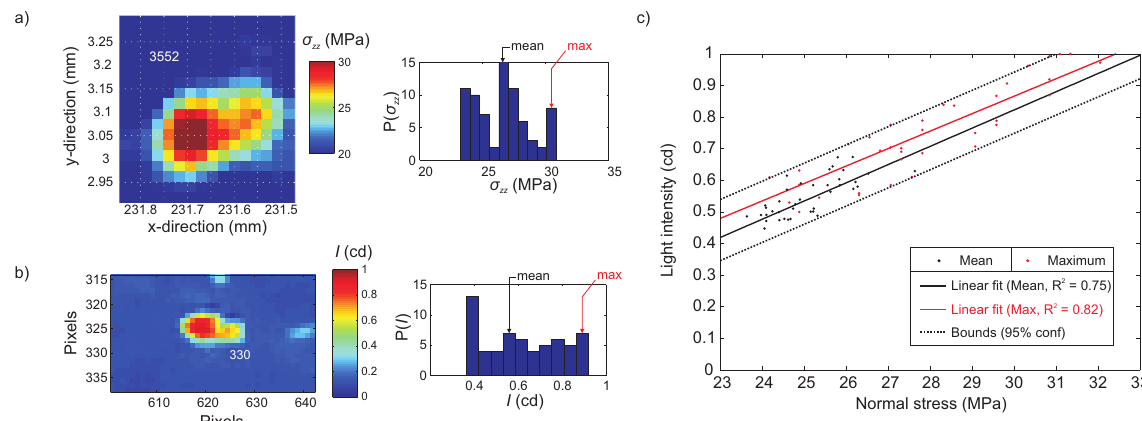
( a ) Normal stress along an asperity measured using the pressure-sensitive film (left). On the right is the histogram of the stress for the same asperity; ( b ) Light intensity transmitted by the asperity in (a) measured using the video camera. The histogram for the light intensity is shown on the right. ( c ) The relation between normal stress and light